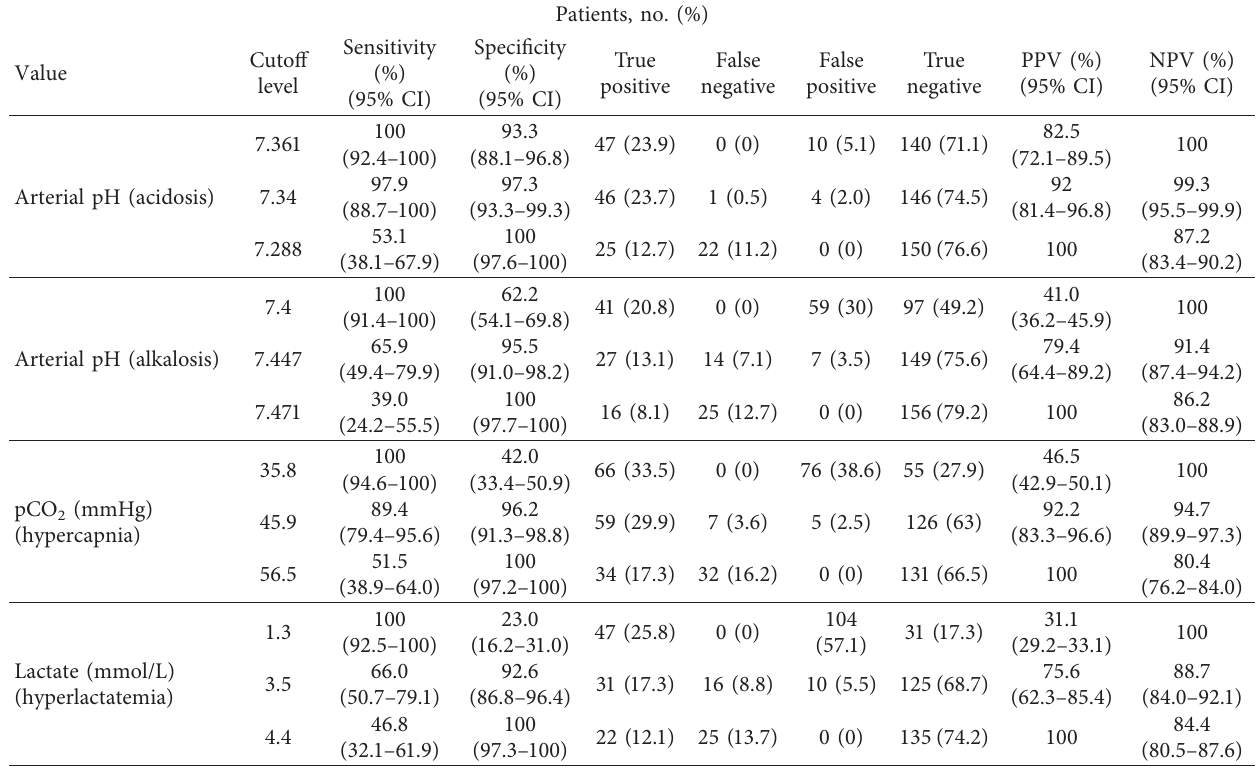
Table 2: Cutoff levels, sensitivity, and specificity for capillary BGA in detecting altered pH, pCO